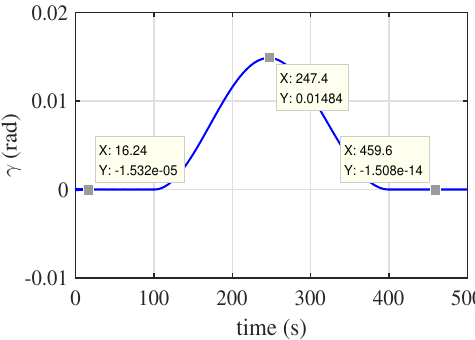
Figure 10. Track angle proposed by PID controller in pitching maneuver and fault free state. As the test in horizontal flight, it is figured out in pitching maneuver flight that the maximum fault rate PID controller can tolerate is 0.15 which is apparently